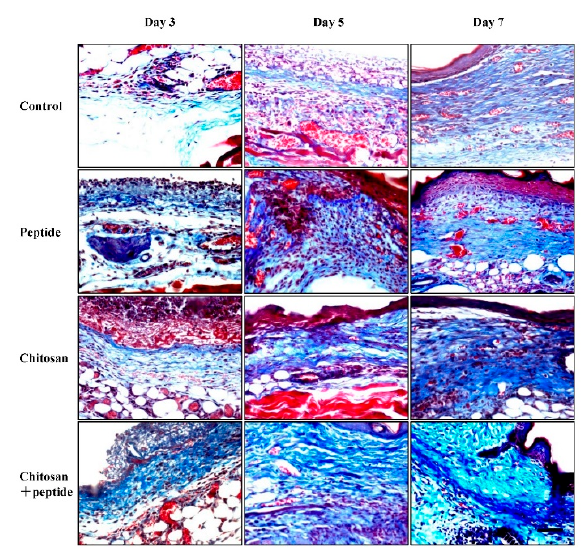
Figure 4. Masson trichrome staining showing the proliferation of new collagen fibers on days 3, 5 or 7 post-trauma in mice in the control, SIKVAV, chitosan, and SIKVAV-modified chitosan groups (scale bar: 50 μ m).